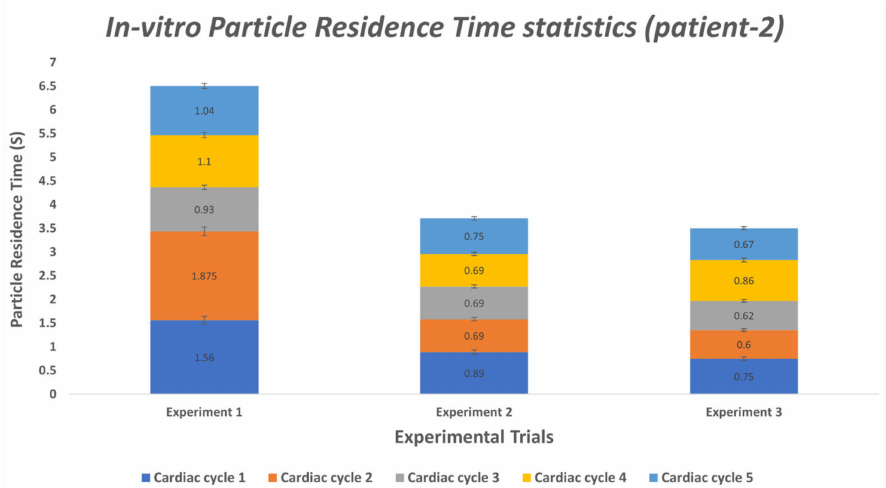
Figure 26. Average PRT values derived from tracked particles over six cardiac cycles in the MPA conduit for patient 1. Each stacked value represents an average PRT in each cardiac